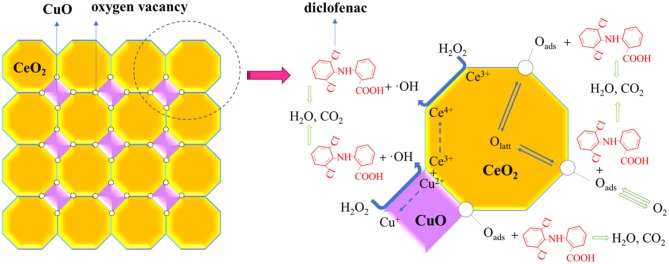
Potential mechanisms of diclofenac degradation in CuO/CeO2-H2O2 system.